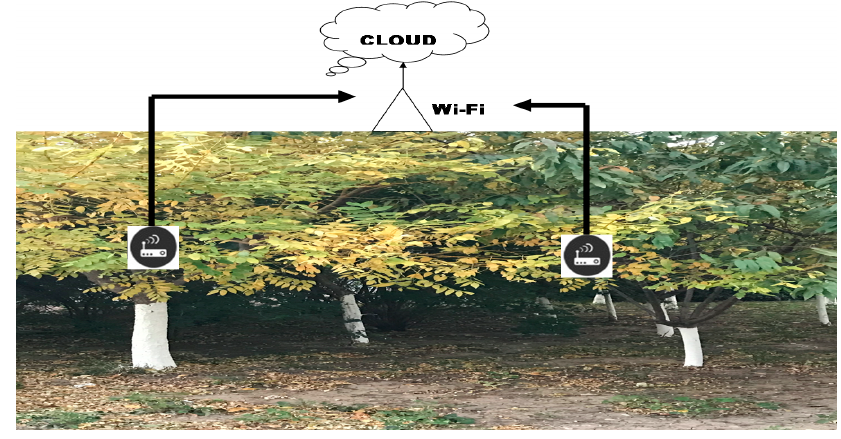
Figure 5. Sensor deployment for forest monitoring [50].